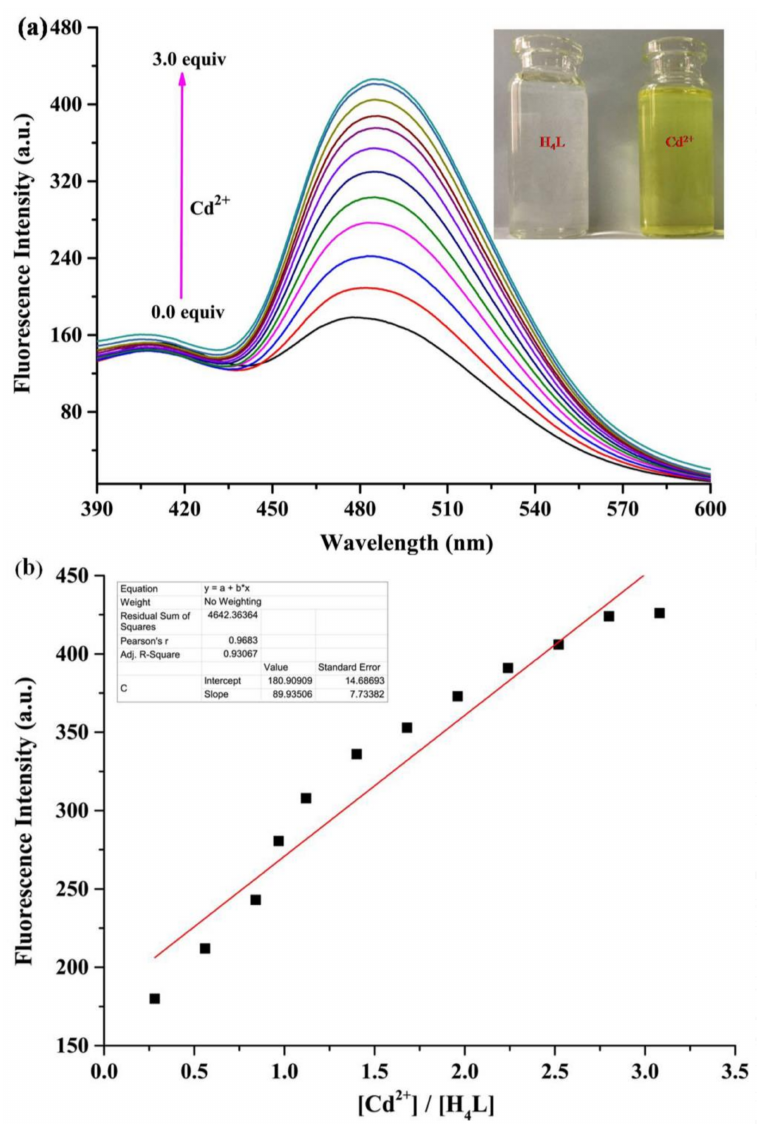
Figure 5. ( a ) Fluorescent emission spectra of sensor H 4 L (1 × 10 − 5 M) with subsequent addition of Cd 2+ (0–3.0 equiv. λ ex = 323 nm) in Tris-phosphate buffer (c = 0.2 M, DMF/H 2 O = 9:1, v / v , pH = 7.0) solutions. Inset: Naked-eyes visible colour changes of sensor H 4 L solution before and after addition of Cd 2+ . ( b ) Linear fitting of sensor H 4 L to Cd 2+ bonding